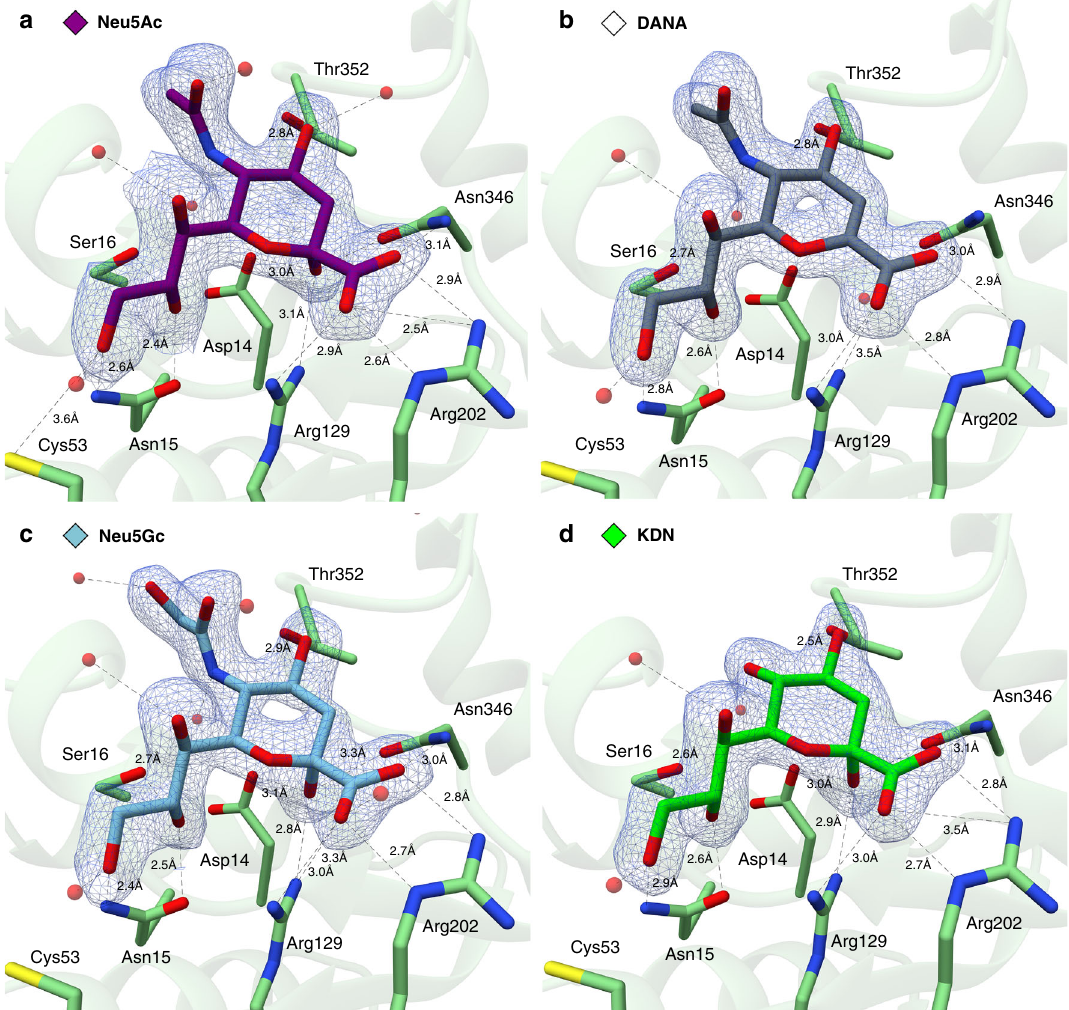
Fig. 4 Crystal structures of EnvSia156 – ligand complexes. The four panels show a detailed view of the crystallized EnvSia156 – ligand complexes within the active center. The enzyme residues making hydrogen-bond contacts (black dashed lines) with the ligands are displayed in stick representation. The ligands are surrounded by a mesh representation of the Refmac5 maximum-likelihood σ A – weighted 2 F o − F c electron density map contoured at 1 σ (0.46 electrons/ Å 3 ), and are colored purple ( a Neu5Ac), gray ( b DANA), light blue ( c Neu5Gc), and green ( d KDN). Water molecules are colored